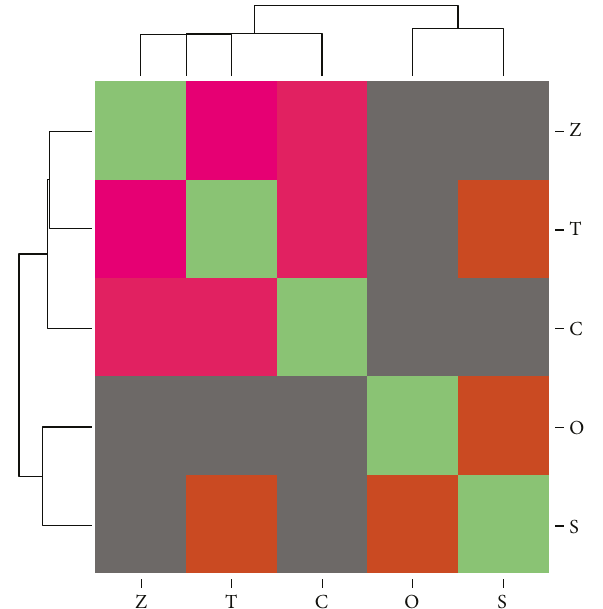
Figure 8: Analysis of the reducibility of the model provides useful information about the similarities of the layers. In our case, the two clusters related to product-process (Z-T-C) and operator- skills (O-S) were revealed. The importance of the de fi nition of the activity types (layer T) is also highlighted.